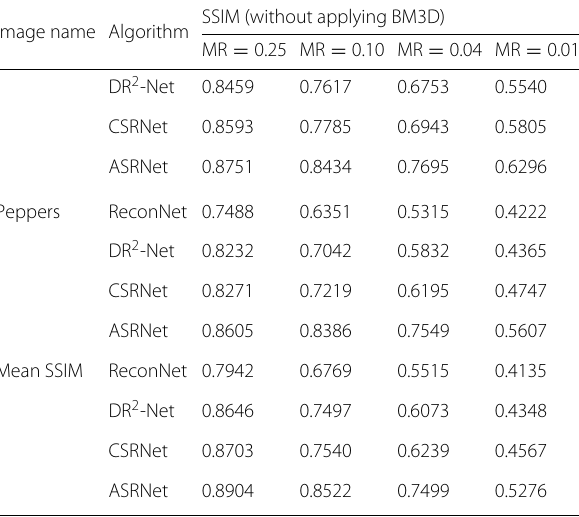
Table 2 SSIM valves in dB for testing image by different algorithms at the ratio MR = 0.25, 0.1, 0.04, and 0.01 SSIM (without applying BM3D) Image name Algorithm